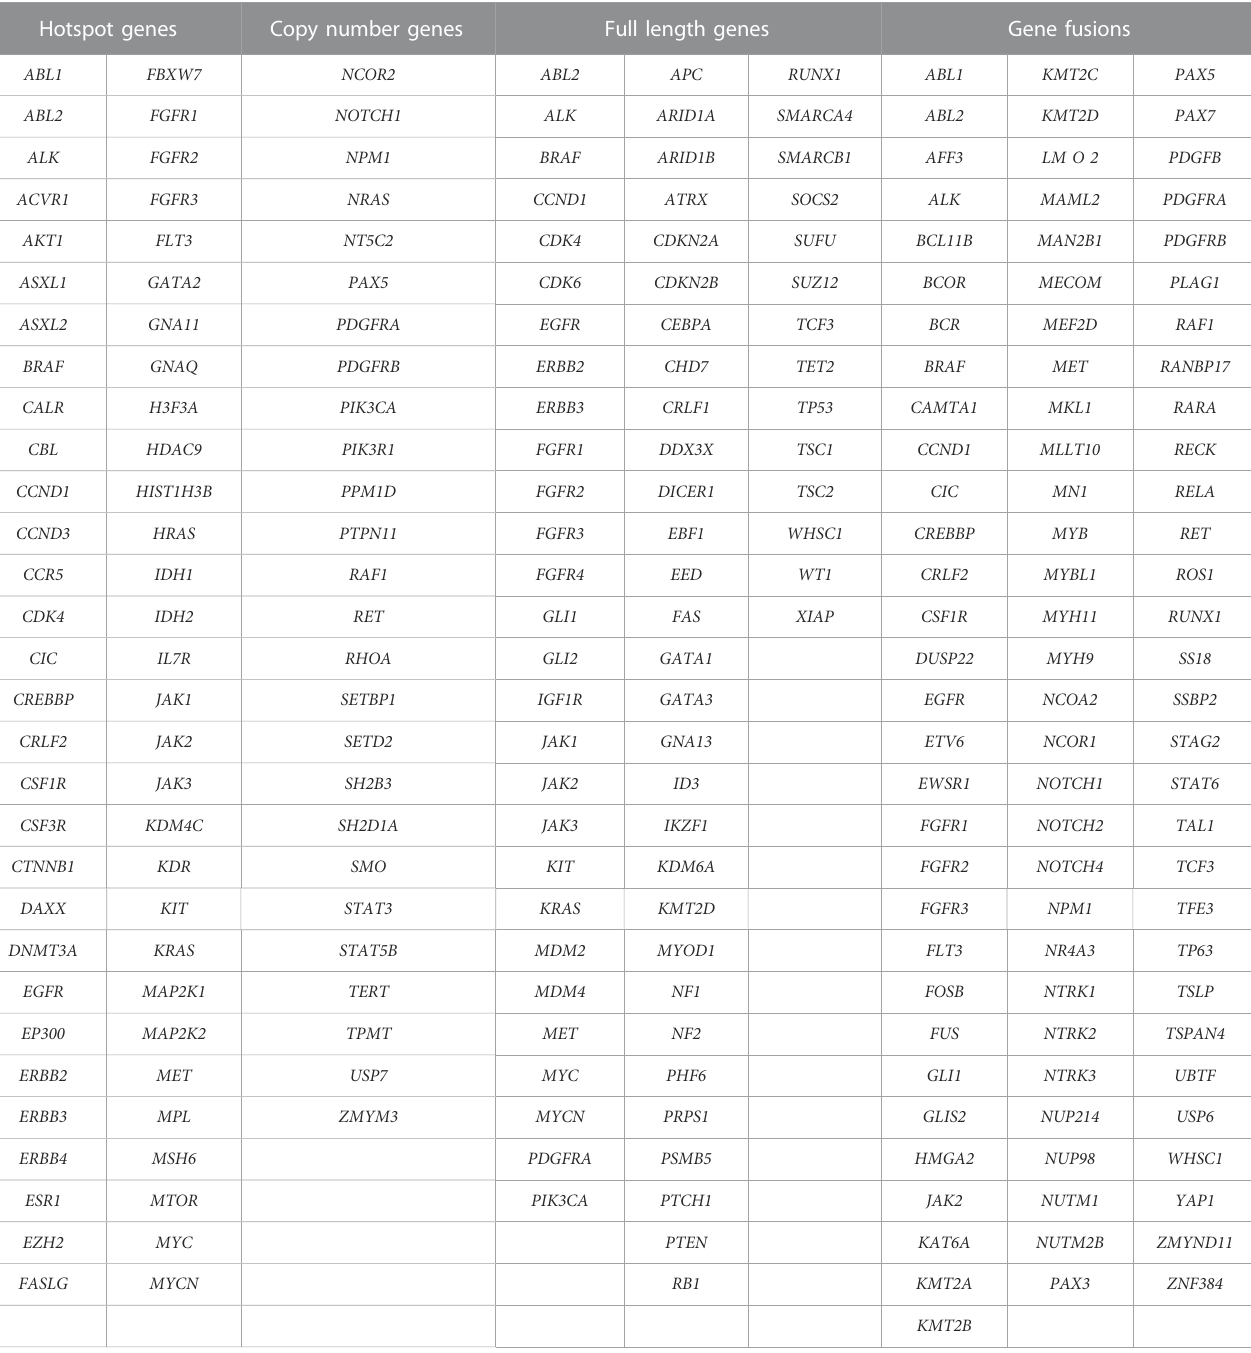
TABLE 1 Panel content (203 unique